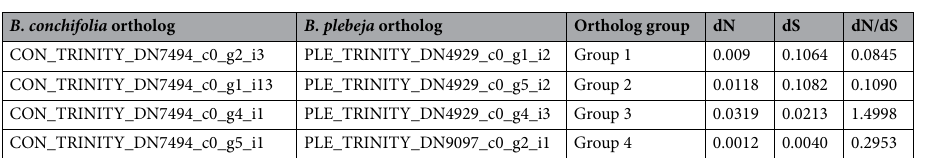
Table 4. Nonsynonymous substitutions (dN), synonymous substitutions (dS) and dN/dS ratio for ortholog pairs. Ortholog group refers to ortholog groupings in Figs. 4 and